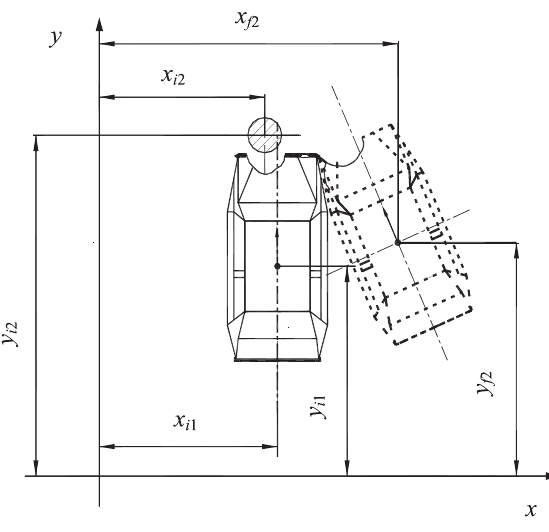
Fig. 8. Scheme of non-central car collision with a tree, a bollard, etc.